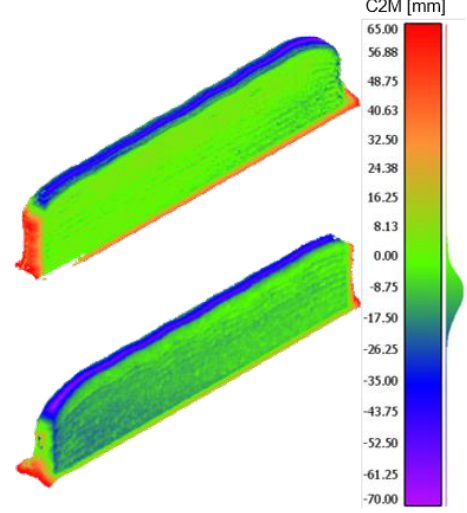
Figure 8 . TLS data is compared to as-designed (Point Figure 10 . Results of the deviation distance analysis of the Cloud) by M3C2 algorithm. printed wall using: (a) C2M, and (b) M3C2. The wax model has the following dimensions namely width, length, and height are: 620 × 1050 × 600 mm. On the other hand, the captured point cloud resulted in the following dimensions: 613.74 × 1056.92 × 617.99 mm - as min and max values on each axis. The maximum difference is in the height which is resulted in approximately 18 mm. This difference is used to assess the max search cylinder depth parameter of the M3C2 algorithm.